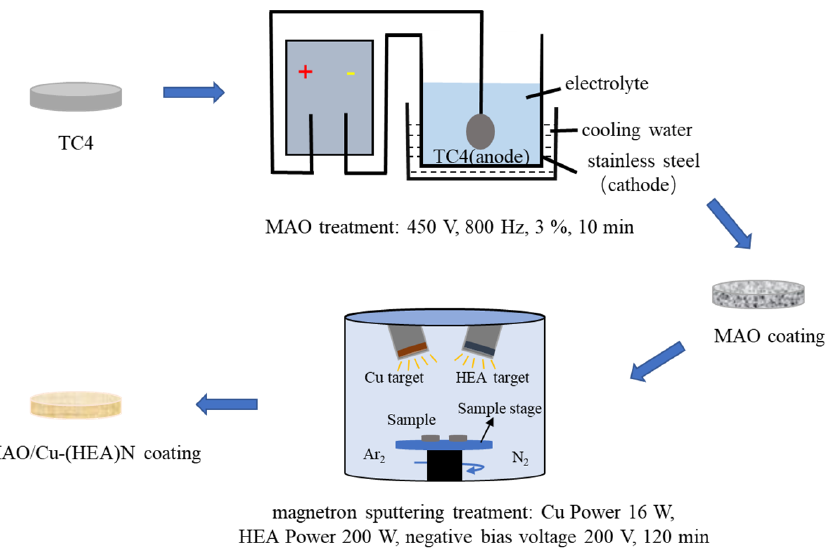
Figure 1. Preparation process of MAO-Cu/Cu-(HEA)N composite coatings.